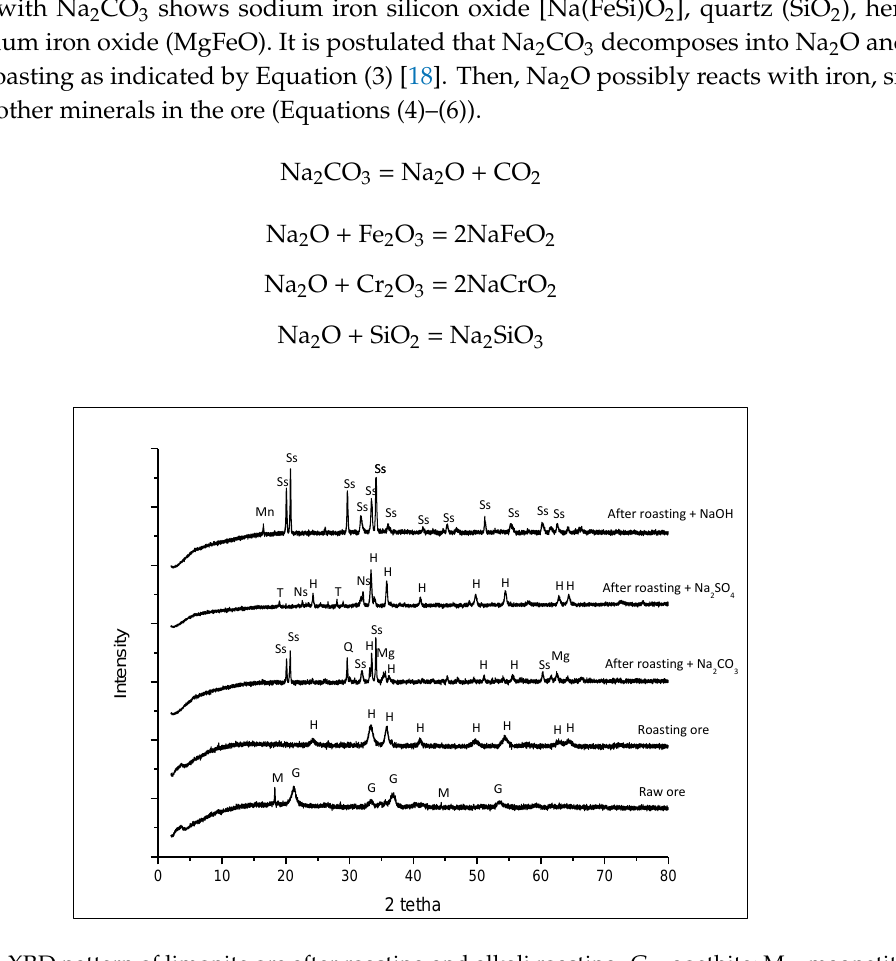
Figure 4. XRD pattern of limonite ore after roasting and alkali roasting. G—goethite; M—magnetite; H—hematite; Ss—sodium iron silicon oxide; Q—quartz; Mg—magnesium iron oxide; T—thenardite; Ns—sodium sulfate; Mn—manganese cyanide.